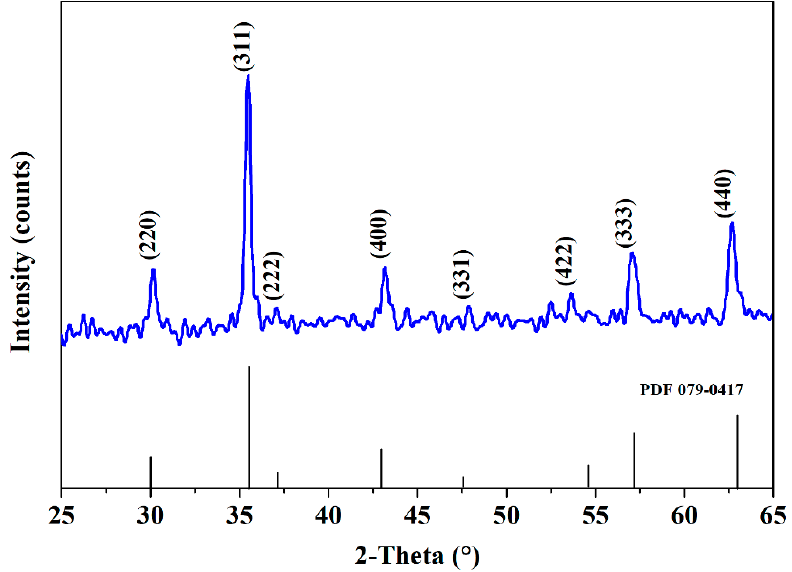
ff raction pattern of Figure 1. Powder X-Ray diffraction pattern of MIONPs. Figure 1. Powder X-Ray di